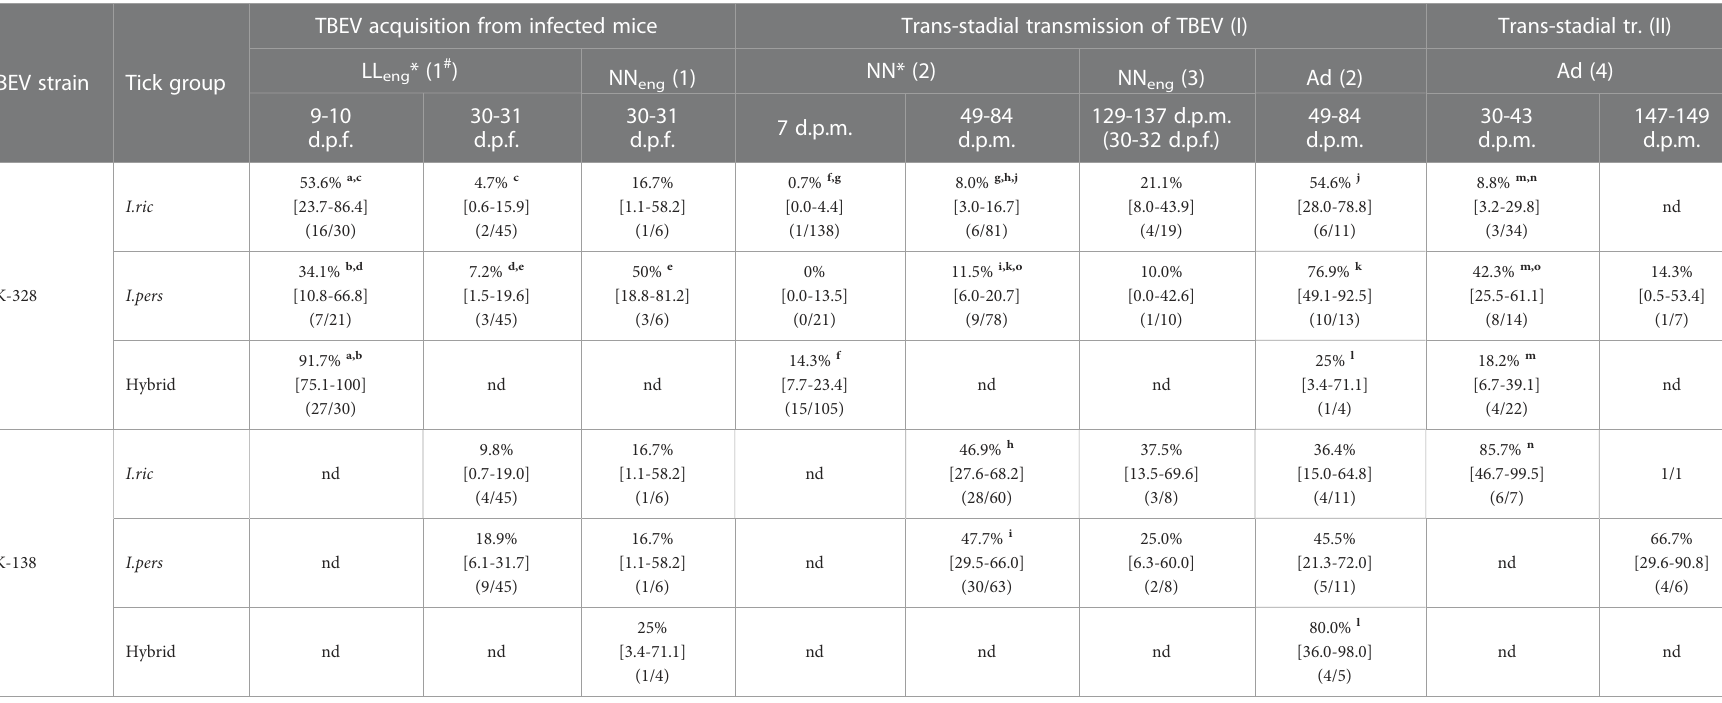
Infection rates of ticks with TBEV determined by qPCR are presented: percentage of positive ticks [CI 95%] (number of positive ticks/total analyzed). I.ric, Ixodes ricinus; I.pers, Ixodes persulcatus , Hybrid, ticks obtained from the mating of I. persulcatus females with I. ricinus males; nd, no data; LL eng , engorged larvae; NN eng , engorged nymphs; NN, questing nymphs; Ad, adult ticks; d.p.f., days post feeding; d.p.m., days